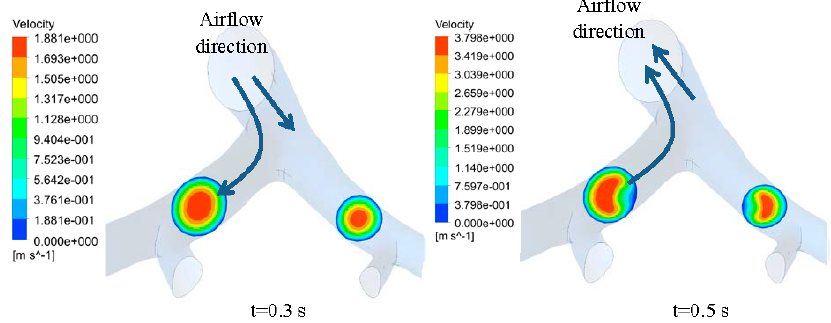
Figure 2. Velocity contour on bifurcation of Generation 5 lung airway, showing tendency to form horseshoe pattern.